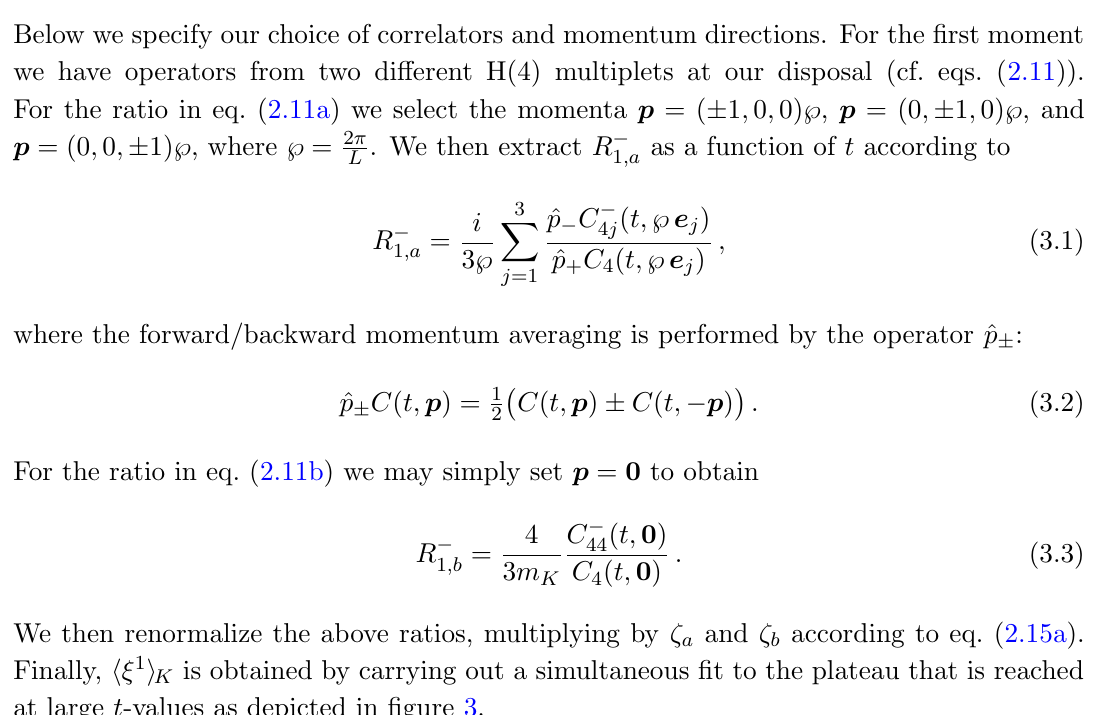
Figure 2 . Schematic illustration of the mass trajectories of the lattice ensembles used in this study. Along the flavor symmetric line (blue) all pseudoscalar mesons have equal mass ( m 2 = m ). The (green) line of the physical average quadratic is equivalent to equal quark masses ( m (cid:29) s + m 2 = phys.) corresponds to an approximately physical mean quark mass meson mass (2 m 2 π K + m phys.). The red line is defined by 2 m 2 = phys. and indicates an approximately (2 m m 2 (cid:29) s ≈ π K − phys.). The gray dot marks the physical physical strange quark mass ( m s ≈